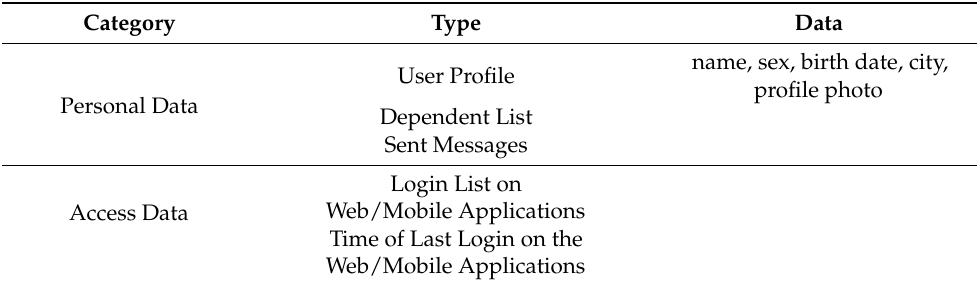
Table 2. Data associated with the use of the SecurHome Mobile